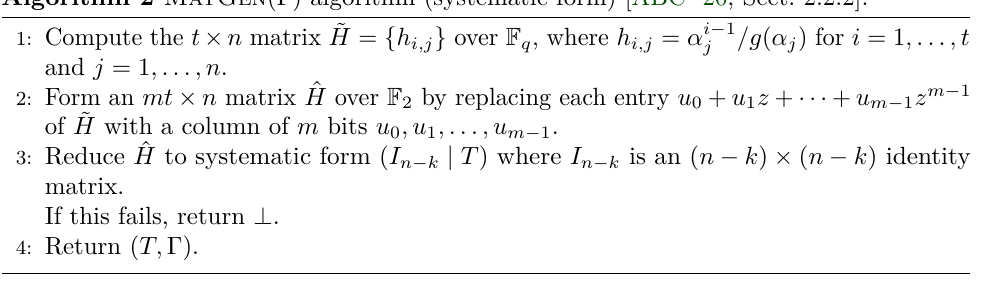
Algorithm 3 Encap ( T ) algorithm with hash-function H [ABC + 20, Sect. 2.4.5].